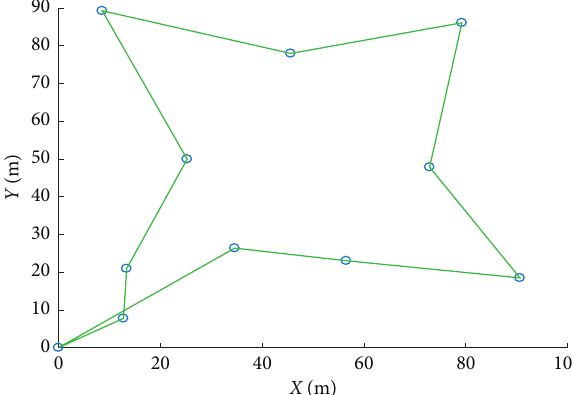
Figure 7: The planned trajectory of a MS at the beginning.